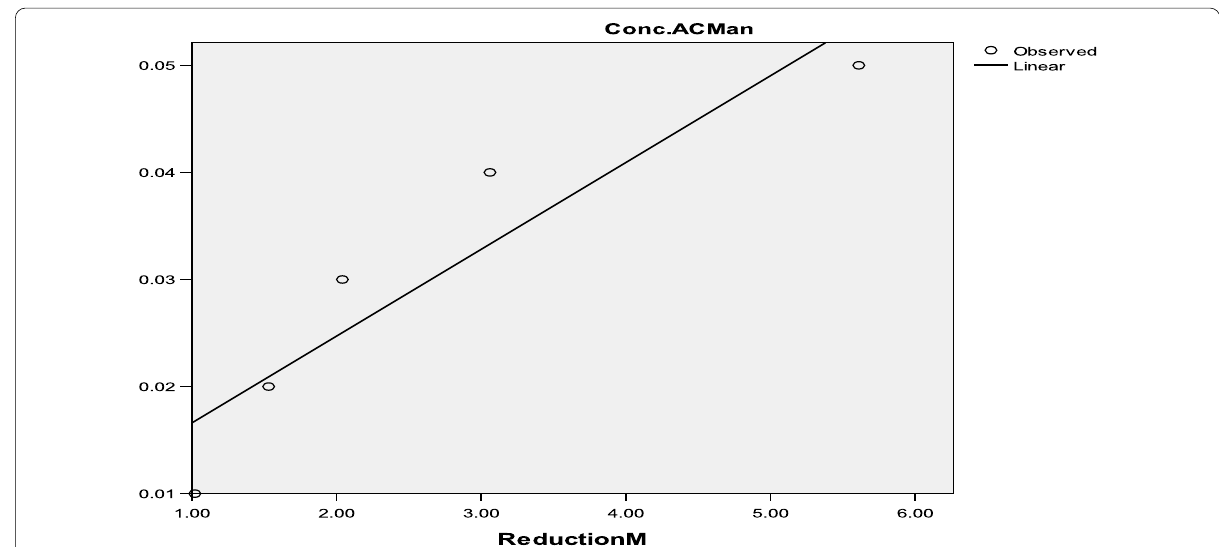
Fig. 1 Correlation between conc. of AC from MS and percentage reduction in methylene blue in wave length of 390